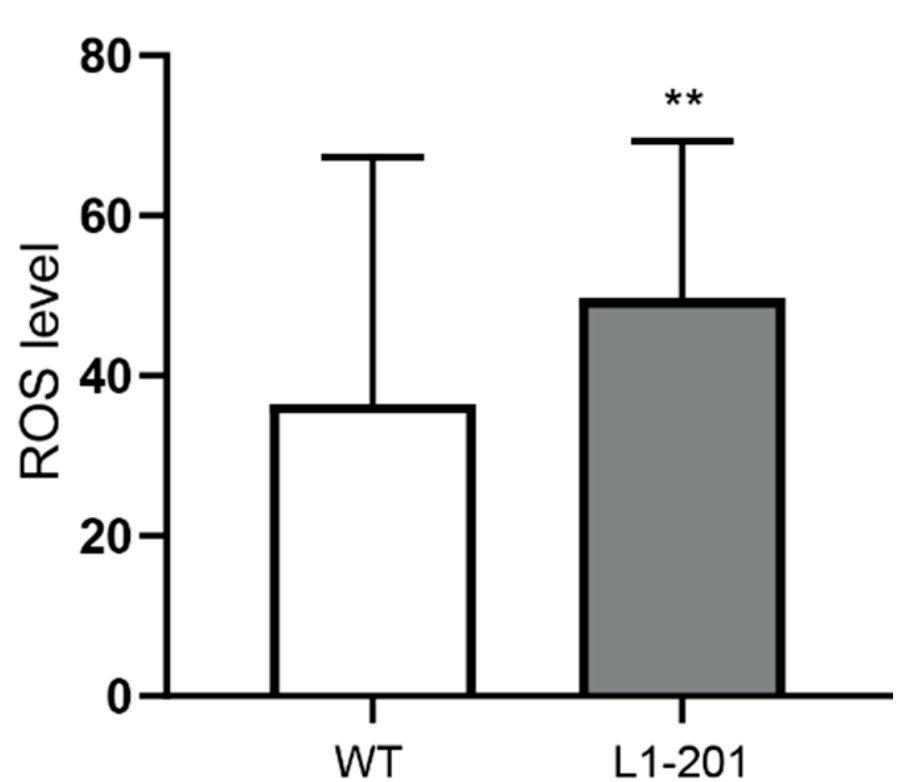
Figure 7. Enhanced levels of ROS in neurons from L1-201 mice. ROS levels were determined in cultured cerebellar granule cells from 6- to 7-day-old male L1-201 mice and their wild-type male littermates. Means ± SD are shown; n = 3. ** p < 0.01(Mann–Whitney test).